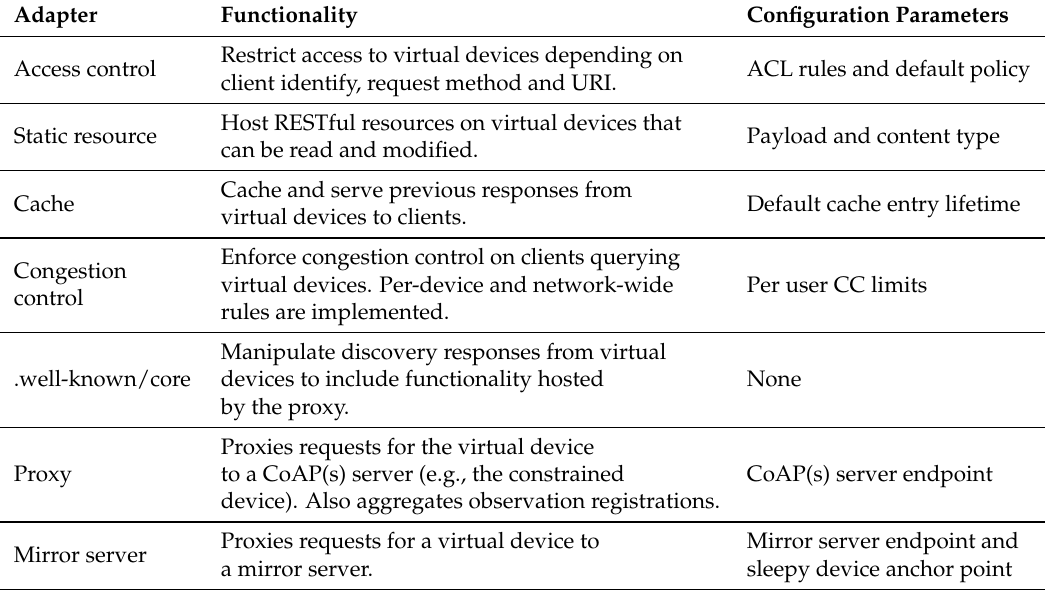
Table 1. The proxy offers a number of functionalities, called adapters, that are hosted on virtual devices. The list of adapters that were implemented at the time of this work are shown in this